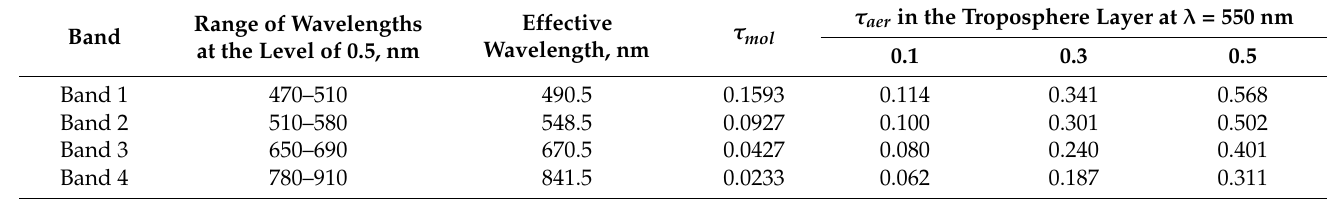
Table 1. Characteristics of MZ channels and the molecular τ mol and aerosol τ aer optical thicknesses of the a priori atmosphere model used in testing.